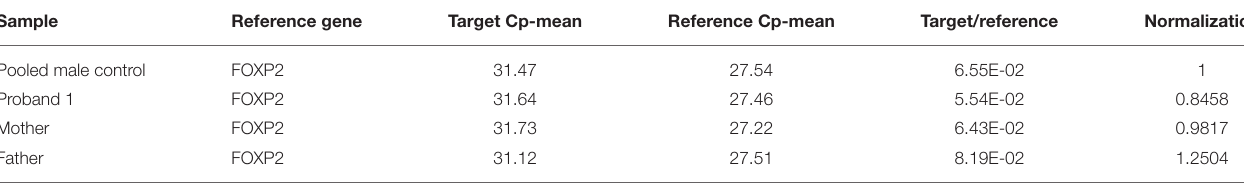
TABLE 1 | Q-PCR analysis results for proband 1, his parents and the five pooled male controls using primer pair 1 at intron 1 of STXBP1 .